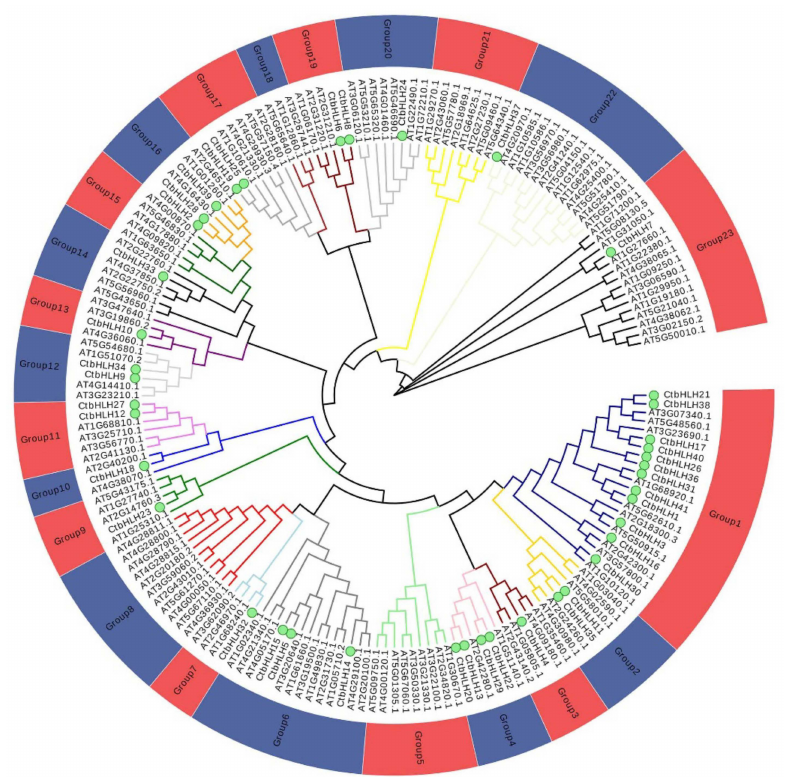
Figure 1. Phylogenetic tree of 179 bHLH proteins from Carthamus tinctorius L. and Arabidopsis thaliana . A neighbor-joining tree was generated using MEGA-X with 1000 bootstrap replicates. Di ff erent background colors represent di ff erent groups of sa ffl ower bHLH subfamilies. CtbHLHs are represented by green